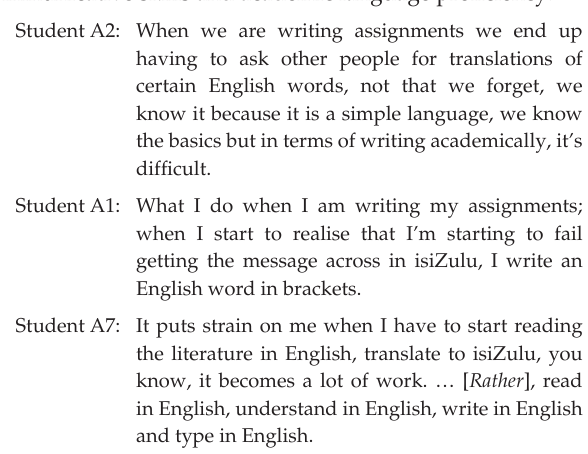
Figure 2 isiZuluVerbal symbols in English Verbal symbols in FIGURE 2: Diagrammatic representation of verbal symbols. FIGURE 2: Diagrammatic representation of verbal